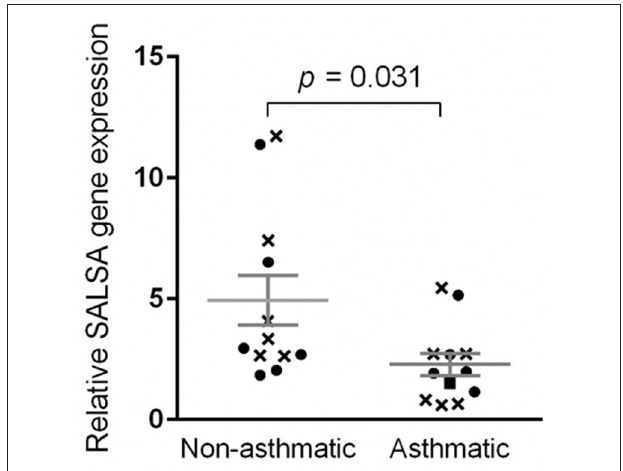
FIGURE 7 | Relative SALSA gene expression was lower in asthmatic relative to non-asthmatic horses. Bar, standard error of the mean. Crosses and circles represent pre- and post-challenge samples, respectively.